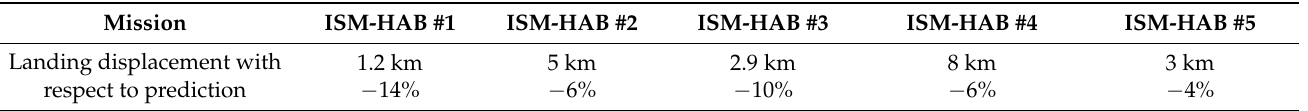
Table 1. Predictor